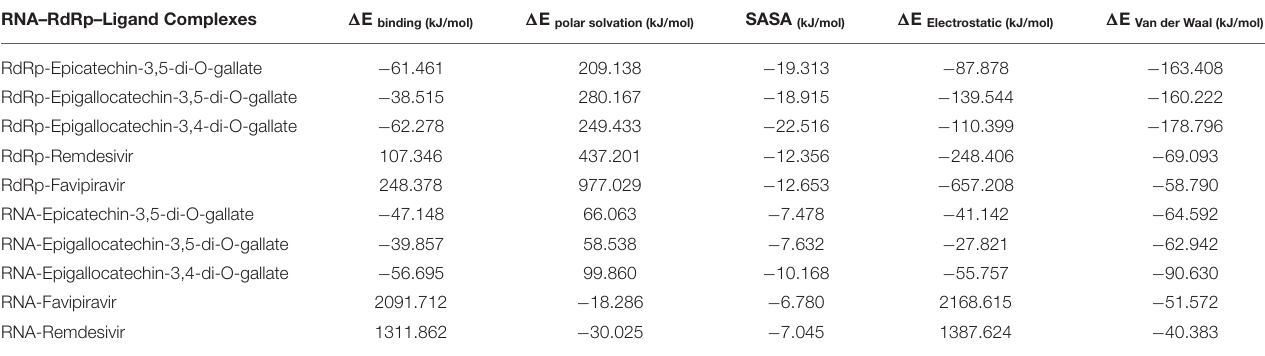
TABLE 2 | Binding free energy (MM-PBSA) calculations for selected complexes. RNA–RdRp–Ligand